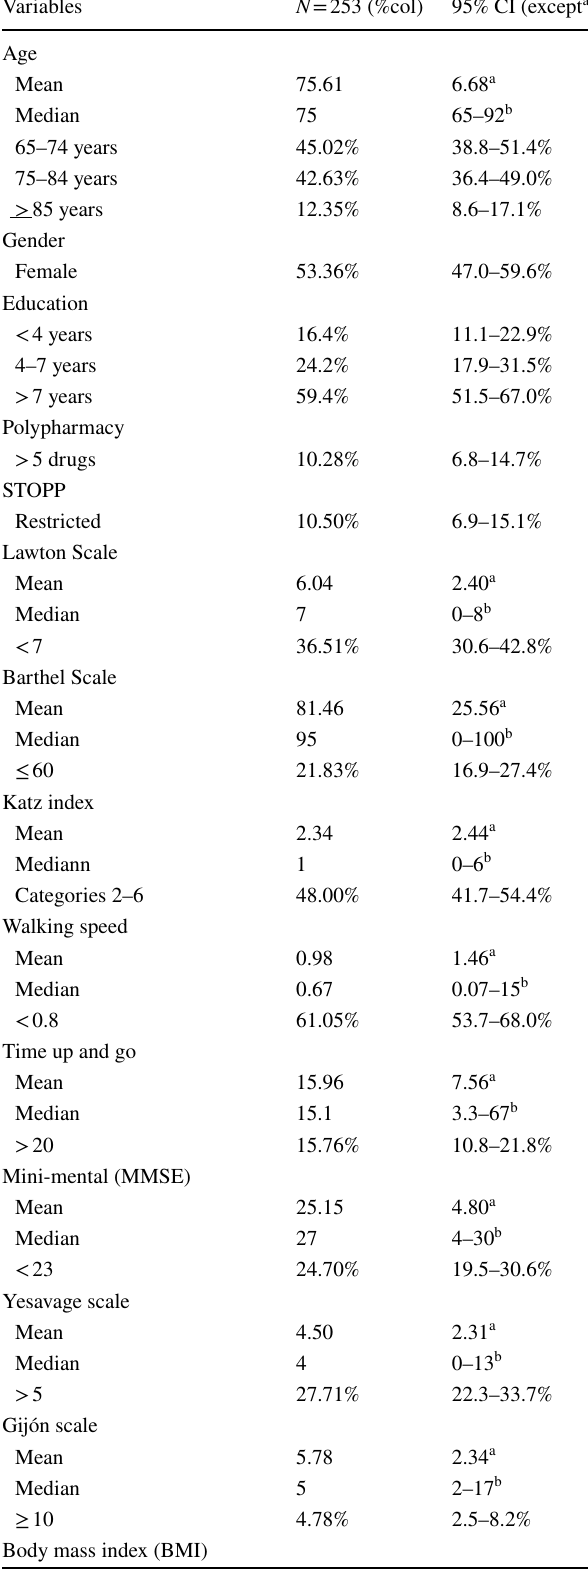
Table 1 General characteristics and geriatric scales included in the comprehensive geriatric evaluation